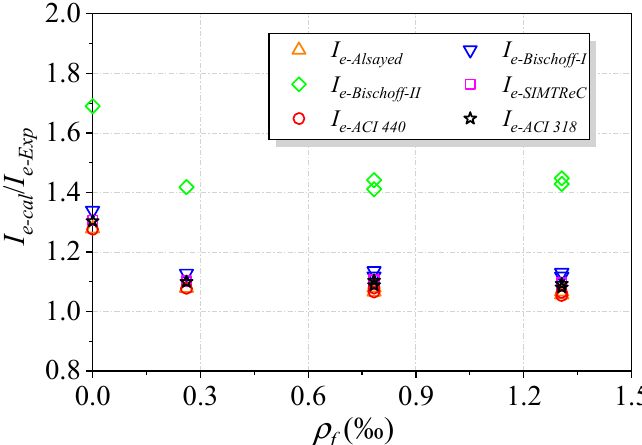
Figure 13. Comparison between the experimental I e values and predictions at a deflection limit of Δ / L = 360.